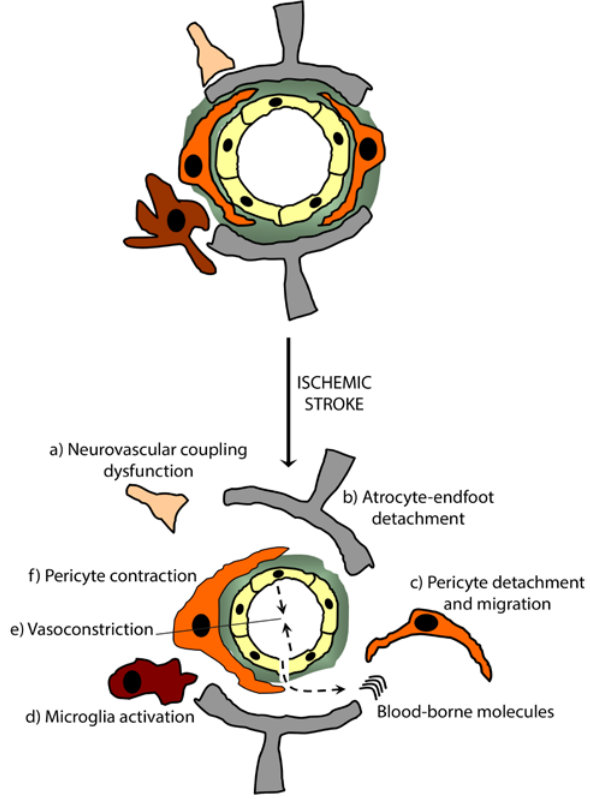
Figure 3. Pericyte responses upon NVU remodeling in ischemic stroke. Upon stroke, the ischemic cascade induces NVU remodeling that causes its loss of function, thus leading to the accumulation of blood-borne molecules into the brain. This loss of function is translated by (a) an impaired rCBF; (b) astrocyte-endfeet detachment; (c) pericyte detachment and migration; (d) microglia activation; (e) vasoconstriction and (f) pericyte contraction. Targeting NVU remodeling, in order to repair, stabilize and restitute the function of the NVU, constitutes a novel approach in developing successful strategies for treating ischemic stroke. This could be achieved by enhancing pericyte survival and in parallel by decreasing their